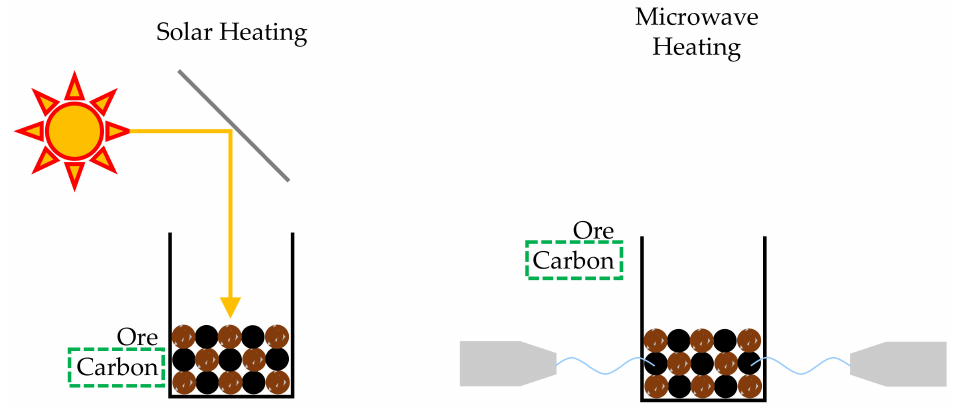
Figure 10. Schematic set-up for solar and microwave heated trials.